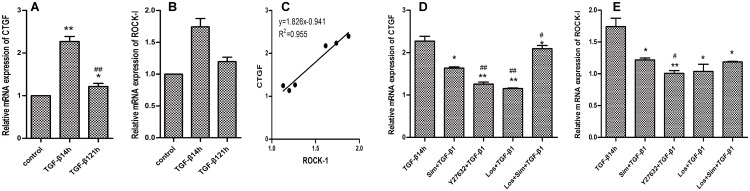
The effects of TGF-β1 on the mRNA expression of CTGF (A) and ROCK-1 (B) in the atrial CFs. (*P<0.05, ** P<0.01 vs control group, #P<0.05, ##P<0.01 vs TGF-β1 (4 h) group). The correlation between the mRNA expression of ROCK-1 and CTGF (C). The effects of Sim, Y27632, and Los and the combined administration of the inhibitors on the mRNA expression of CTGF (D), ROCK-1 (E) in the atrial CFs stimulated by TGF-β1. *P<0.05,**P<0.01 vs TGF-β1 group, #P<0.05, ##P<0.01 vs Sim+TGF-β1 group.(n = 5 for each group).